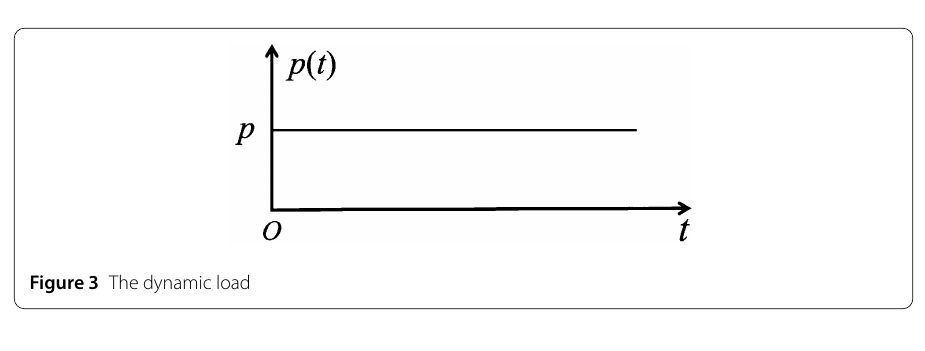
Figure 4 The node distribution of the cantilever beam